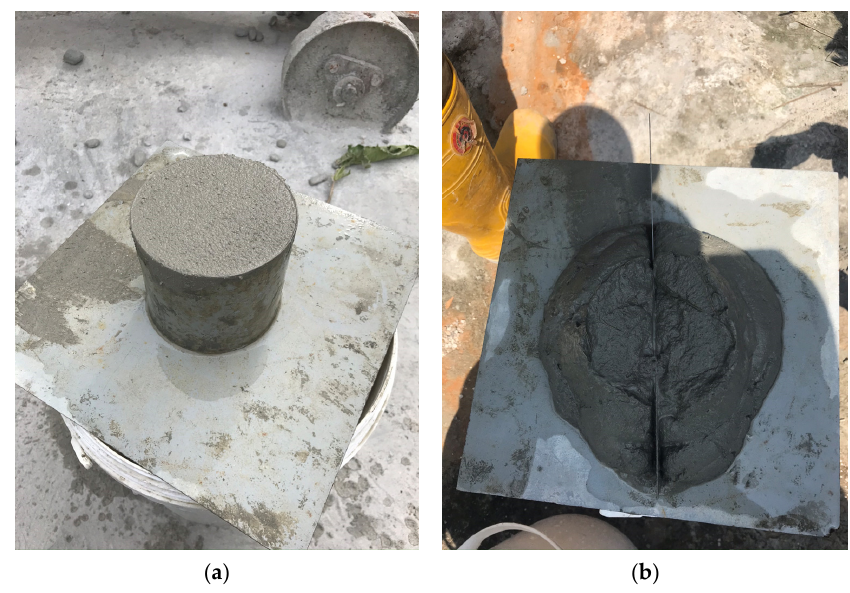
Figure 7. Flow table test. ( a ) long cylinder. ( b ) measurement of spreadability.